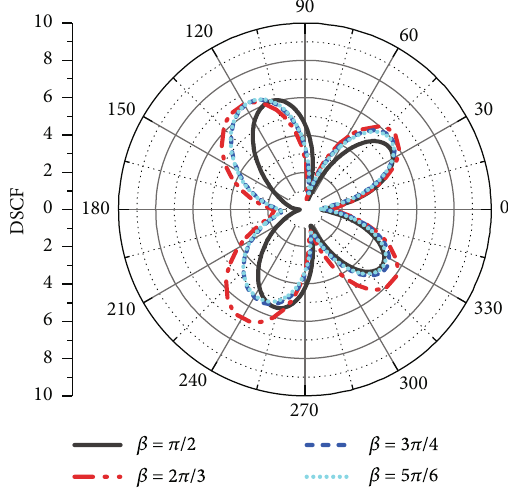
Figure 13: DSCF distribution of the circular hole with di ff erent β ( r / r 2 = 1 : 0 ).